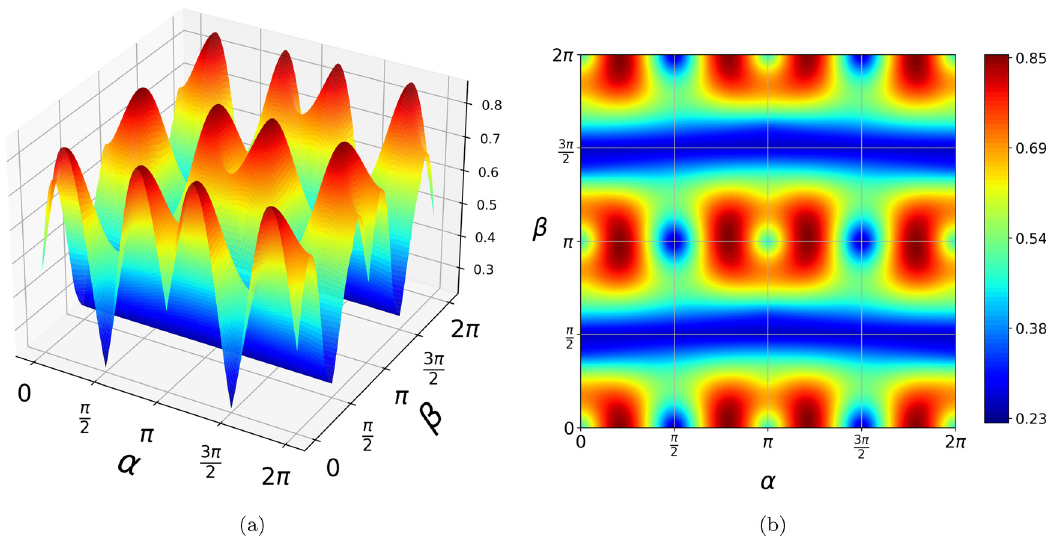
Figure 5: Solution space for case 1 based on equation ( 19 ) . ( a ) 3D - graph for case 1. ( b ) Contour for case 1.